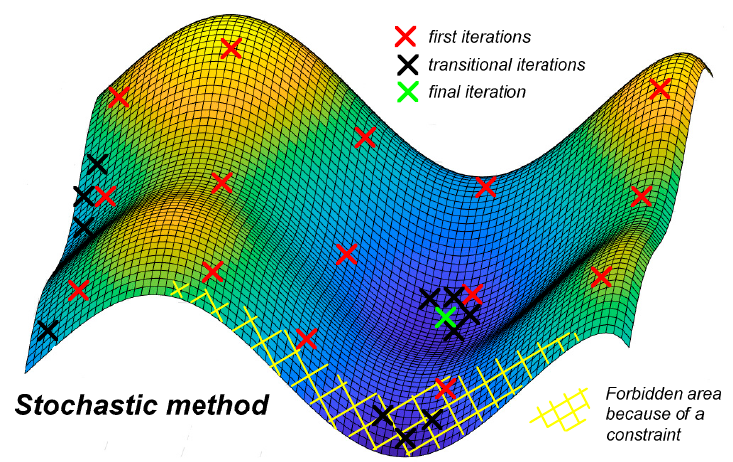
Figure 2. Illustration of optimization with a stochastic algorithm.